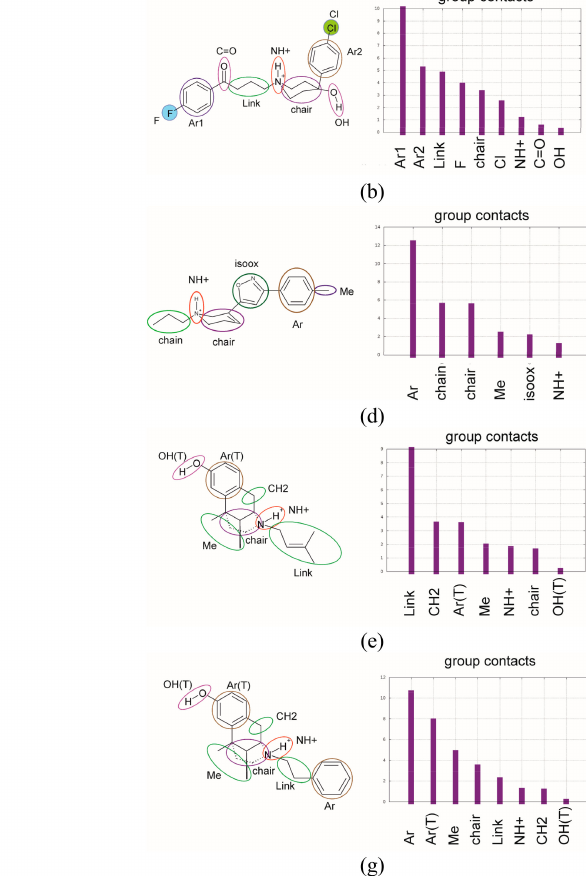
Figure 3. The contact analysis for the ligand moieties (left panel) with receptor (right panel) presents time-averaged histograms and the frequency of contacts with the moieties of ligands: ( a ) FENT, ( b ) HALO, ( c ) MORPH, (PD-144418), ( d ) R -PTZ, ( e ) S -PTZ, ( f ) R -PHZ, ( g ) S